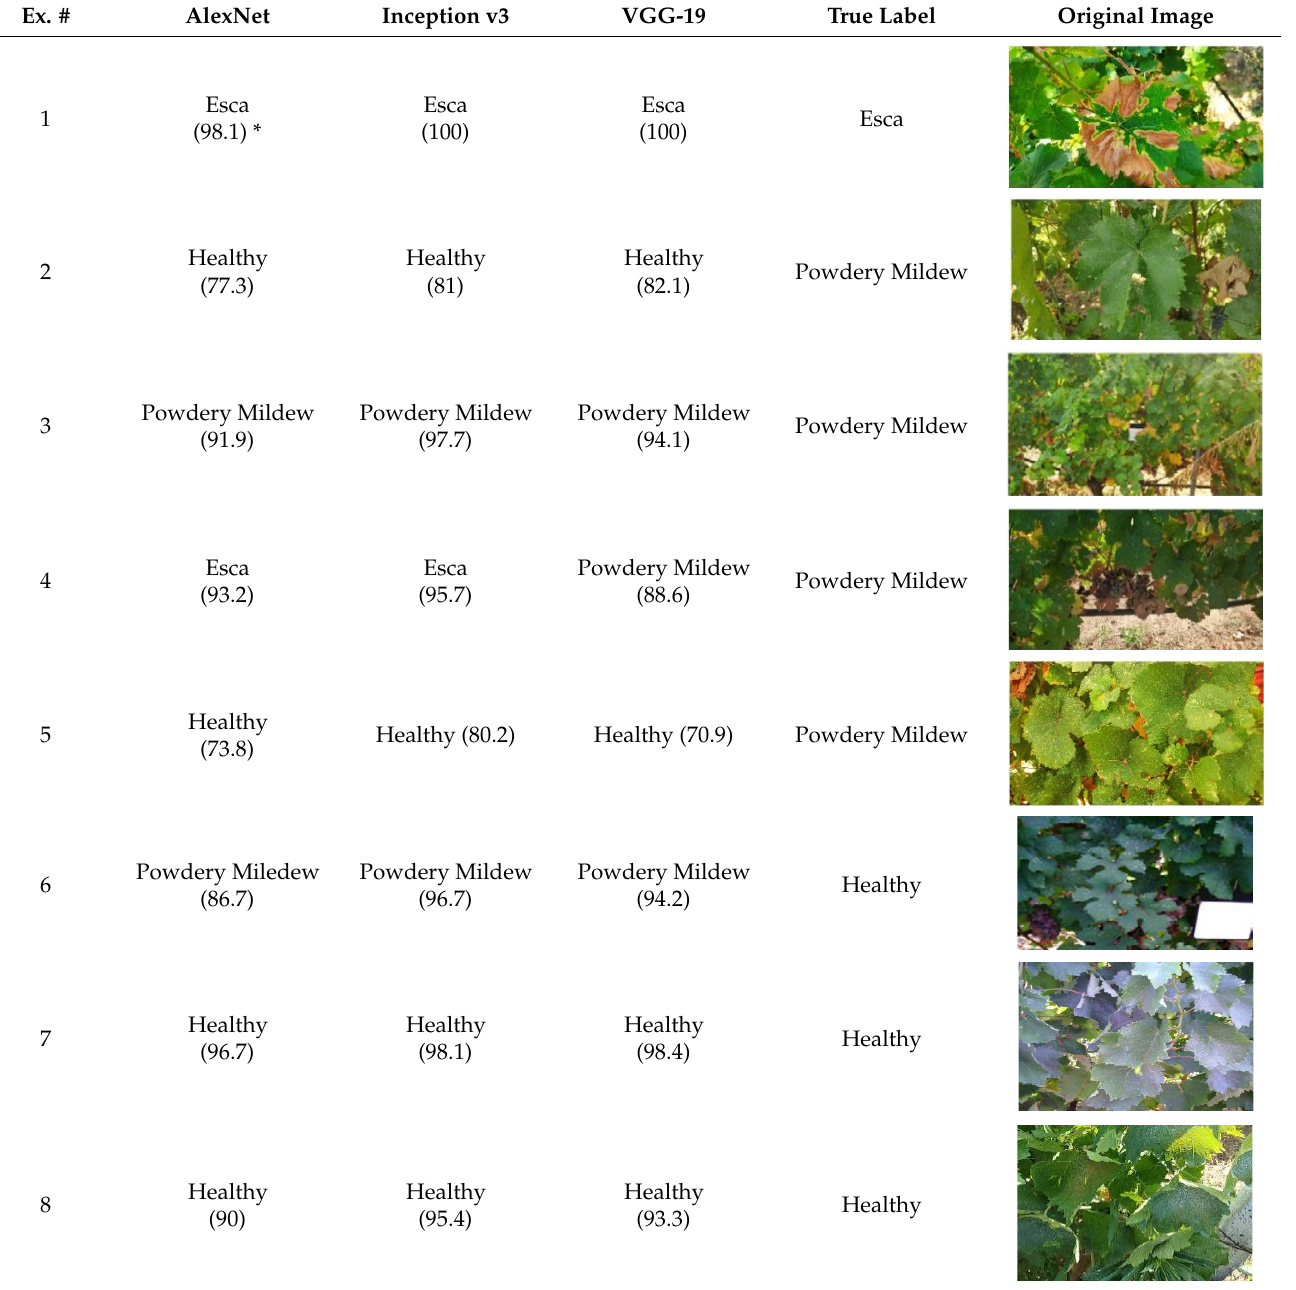
Table 13. AlexNet, Inception v3, and VGG-19 trained with fine-tuning and a three-layer neural net- work in the last FC layer. Model evaluation (testing phase) gives examples of untrained images from Chatzivariti’s vineyard